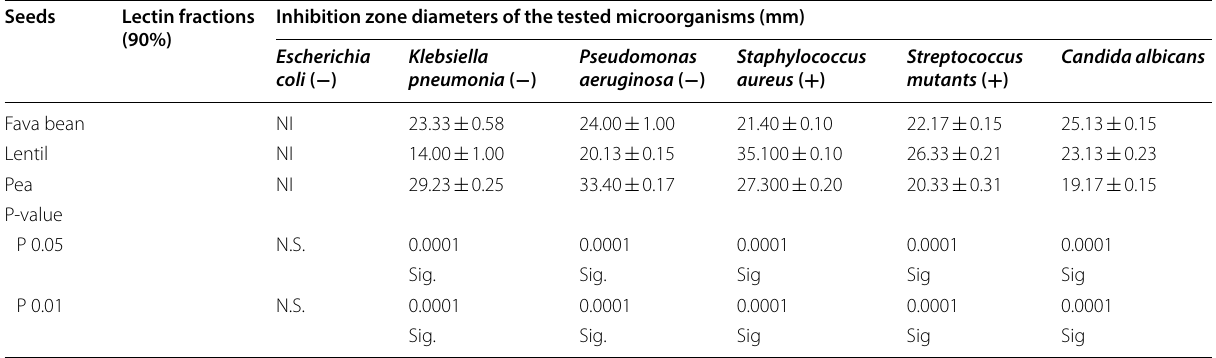
Antimicrobial activity measured as inhibition zones diameters (mm) The results are represented as mean of three replicates with NI no inhibition zone; mm millimeter, Sig. significant, N.S. not significant, ( P‑value 0.05 and 0.01 considered statistically significant (95 and 99% confidence ≤